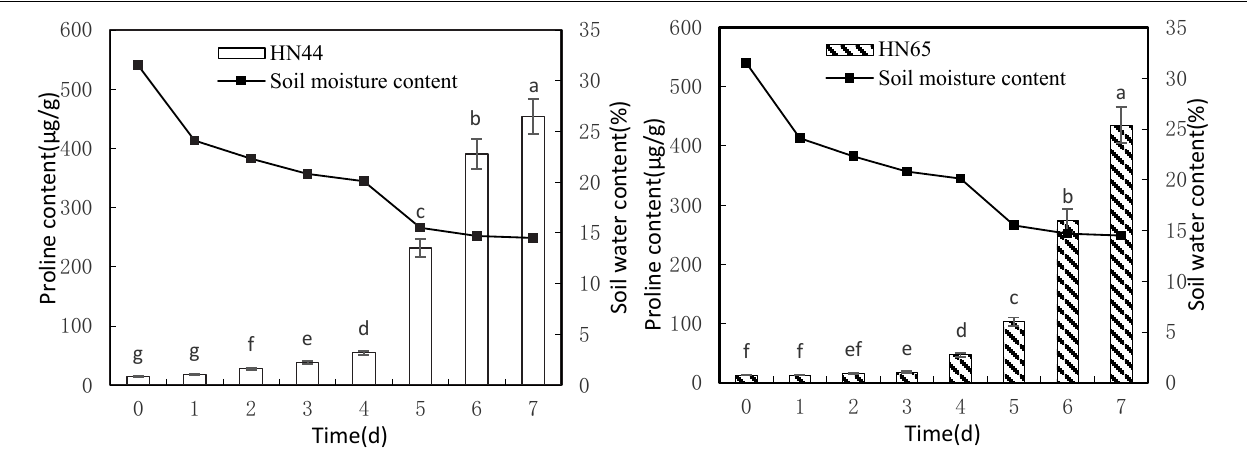
FIGURE 2 | Effect on proline content under different soil water contents. Indicates that the values marked with different letters are significantly different, and those marked with the same letter are considered to be statistically